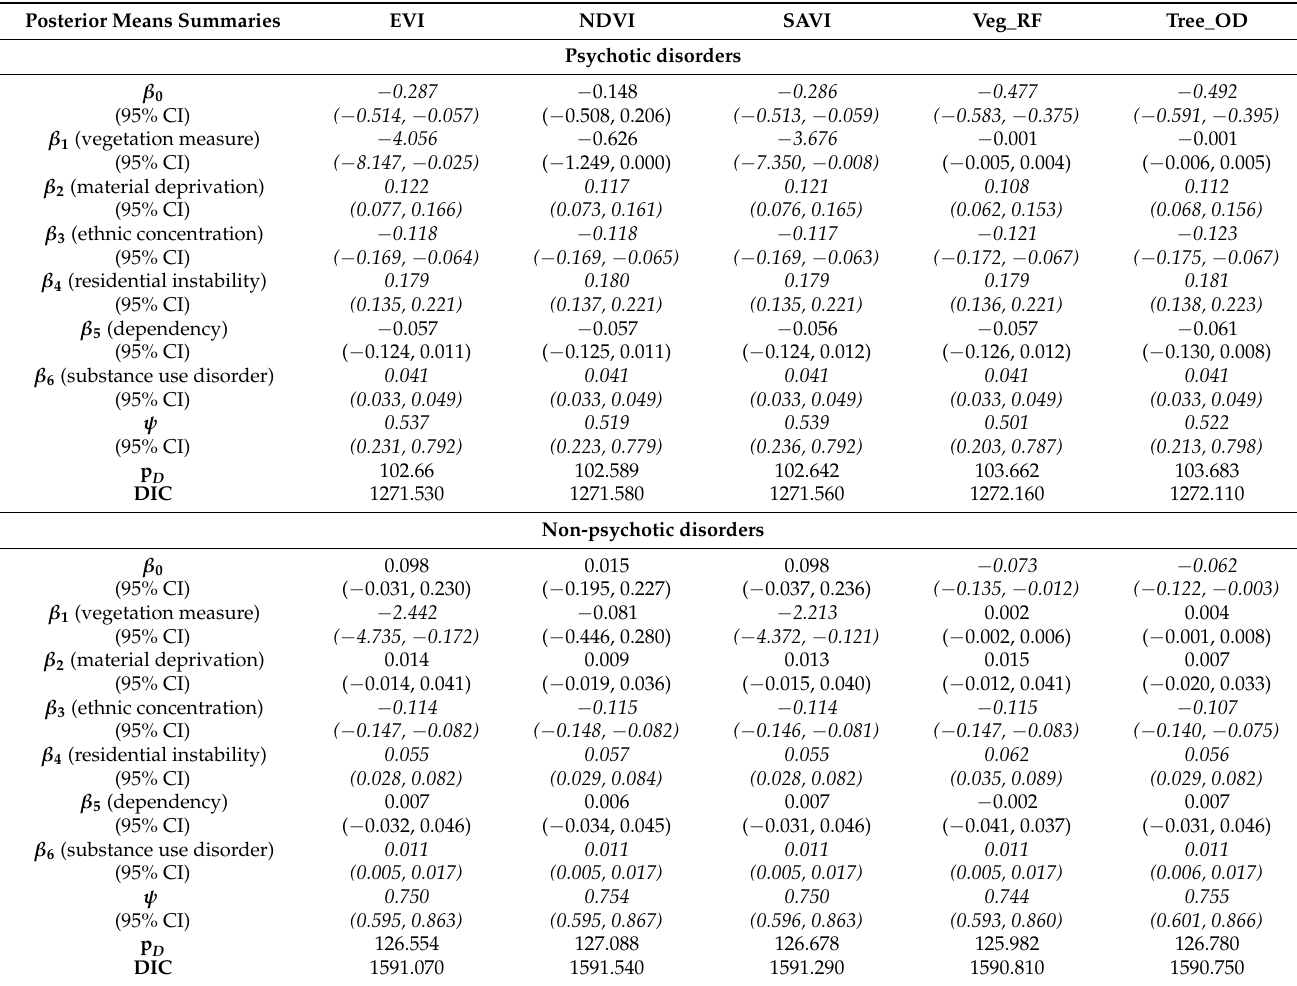
Table 4. Summaries of results from Bayesian spatial modeling to analyze the association between vegetation and psychotic and non-psychotic disorders. The italicized values are significant at a 95% credible interval (CI). Posterior Means